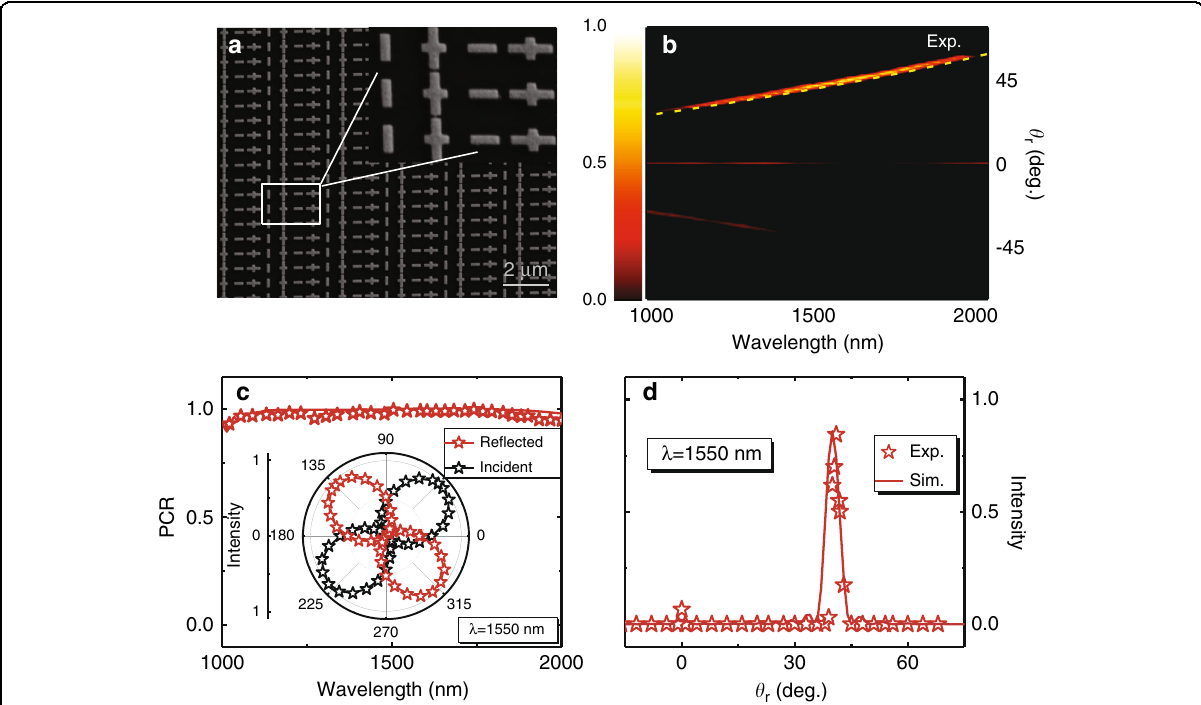
Fig. 5 Experimental demonstration of an anomalous-re fl ection half-wave plate. a SEM image of the fabricated metasurface. b Measured normalized far- fi eld intensity versus receiving angle and wavelength of light re fl ected by the metasurface when illuminated by normally incident LP light with an E - fi eld polarized along an angle of 45 (cid:7) with respect to the x -axis. The yellow dashed line represents theoretical predictions by the generalized Snell ’ s law. c Measured (star) and FDTD-simulated (line) PCR spectra of the metasurface. Inset: measured and simulated polarizer- fi ltered intensity patterns of light re fl ected by our meta-device and an Au mirror, both under illumination by normally incident LP light at 1550 nm. d Measured (star) and simulated (line) angular distributions of the normalized intensity of light re fl ected by our meta-device under the